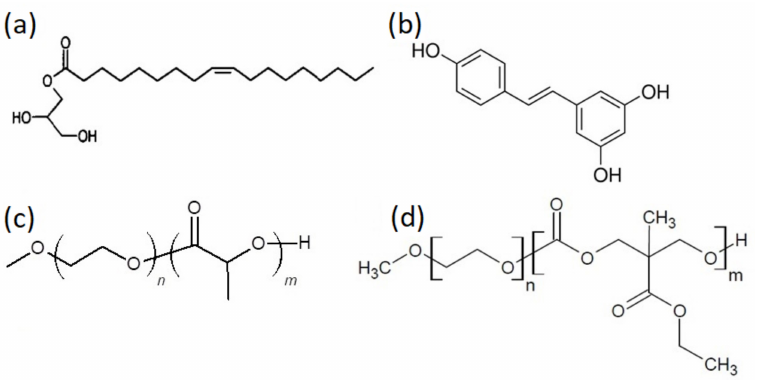
Chemical structures of ( a ) glyceryl monooleate (GMO) lipid, ( b ) resveratrol, ( c ) poly(ethylene oxide)- b -poly(lactic acid) (PEO- b -PLA), ( d ) poly(ethylene oxide)- b -poly(5-methyl-5-